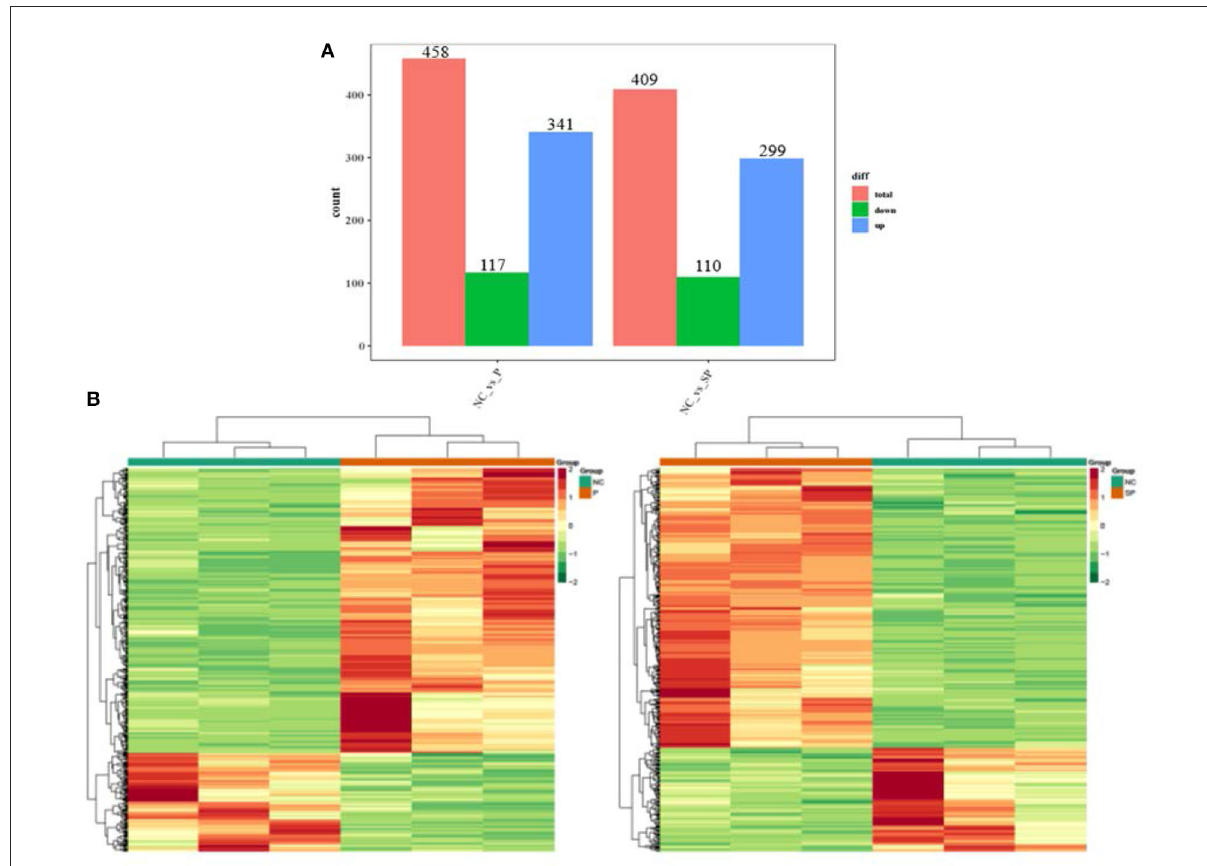
FIGURE1 Analysis of DEGs. (A) Statistics of differentially expressed genes; (B) Clustering heat map of differentially expressed genes expression (red corresponds to upregulation, green corresponds to downregulation).